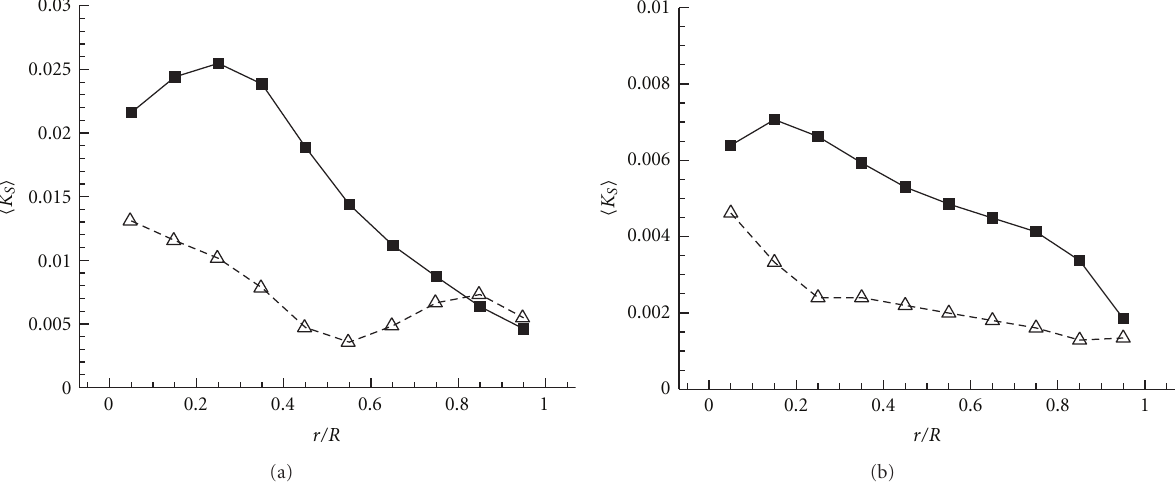
Figure 11: Side-force magnitude on radially divided blade sections at J = − 1 . 0: (a) w/hull, (b) w/o hull ( (cid:2) suction side, (cid:4) pressure side).